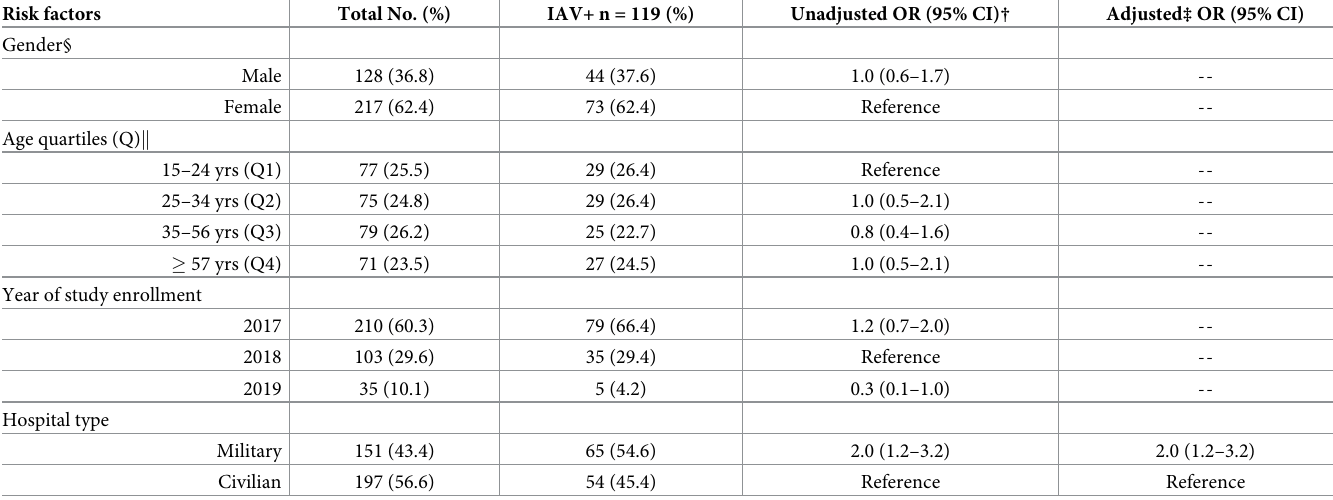
Table 3. Unadjusted and adjusted risk factor associations for Influenza A Virus (IAV) detection � among patients with severe acute respiratory illness in the Hanoi area,